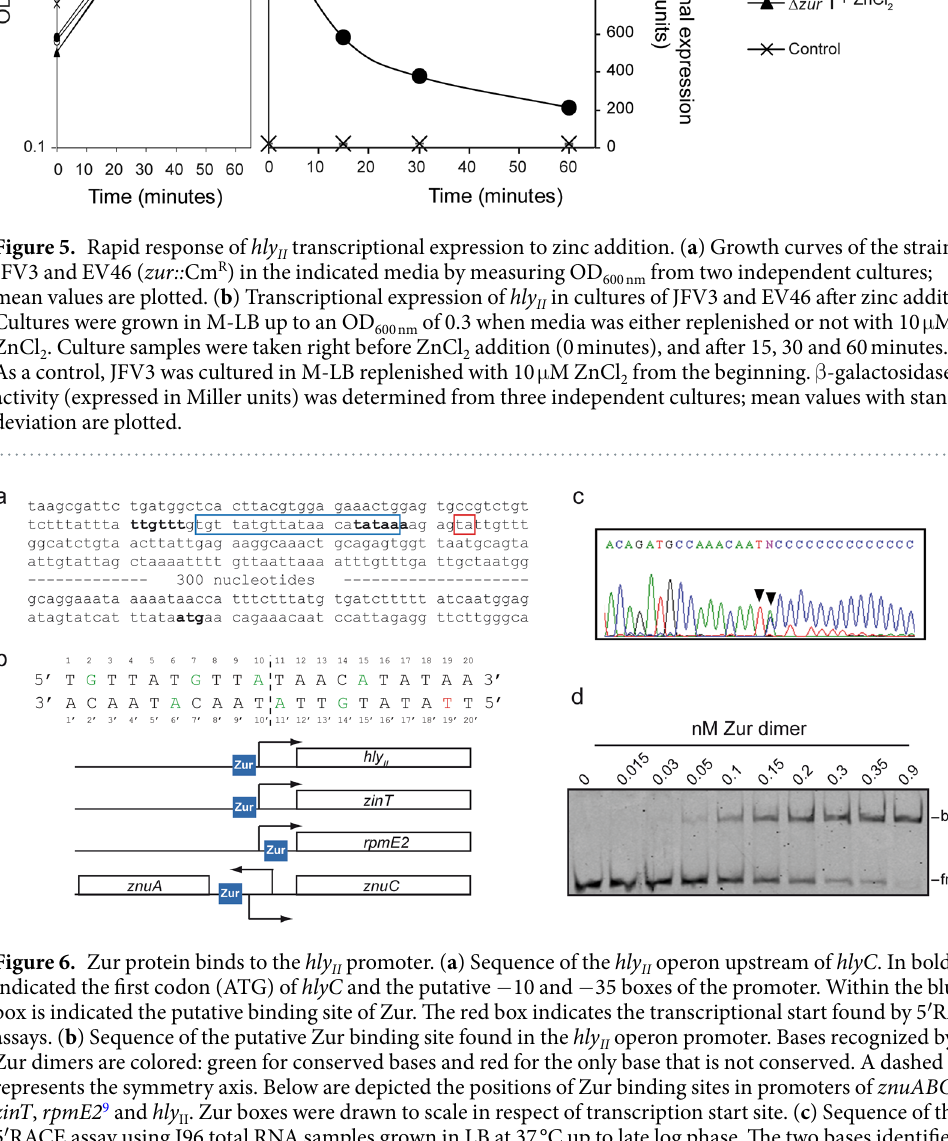
The fast response to ZnCl 2 of hly II transcriptional expression suggested that Zur directly represses the hly II pro- moter. Zur regulates transcription by cooperative binding of two dimers to a well-characterized DNA sequence located in the vicinity of the promoter of Zur-regulated genes 9,31 . Using the consensus sequence reported 31 for the E . coli Zur box (RNNNYRNNRYNNYRNNNY), the J96 hly II promoter sequence was scrutinized, revealing a putative Zur binding site (Fig. 6a and b). The bases of the Zur box involved in establishing hydrogen-bonds with Zur have been identified 31 and are indicated in Fig. 6b. The motif found in the J96 hly II promoter sequence was highly conserved except for the base G19 ′ (see Fig. S3). It must be noted that G19 ′ is one of the least determinant bases for Zur binding 31 .